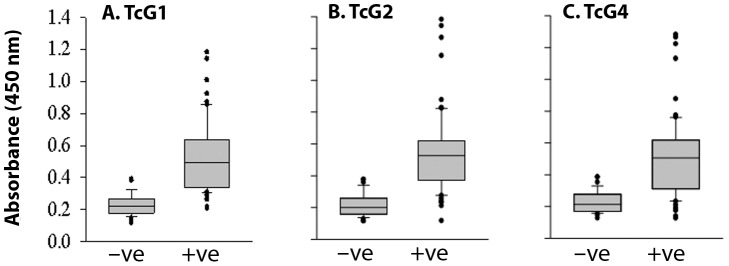
TcG1, TcG2 and TcG4 are recognized by antibody response in human subjects from Mexico.Sera samples obtained from volunteers living in the endemic areas of Chiapas Mexico were characterized as seropositive (+ve) and seronegative (−ve) by whole-parasite antigen based serology tests in the 1st phase. The TcG1 (A), TcG2 (B) and TcG4 (C) specific antibody response was measured by ELISA, and data are presented as box plot (details in Fig. 1).